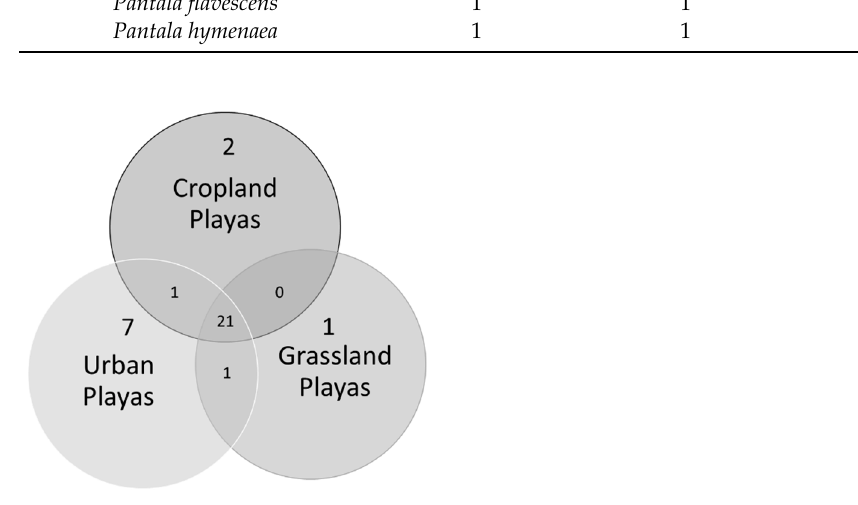
Figure 2. Venn diagram of odonate species occurrences at playa wetlands in the Texas panhandle (United States), 2003–2020, characterized by the dominant land use/land cover type within 200 m. Grassland, cropland, and urban playas had 21 odonate species in common. Table 1. Odonate species occurrences (“1” indicates presence) listed taxonomically in playa wet- lands characterized by the dominant land use/land cover type within 200 m, Texas panhandle